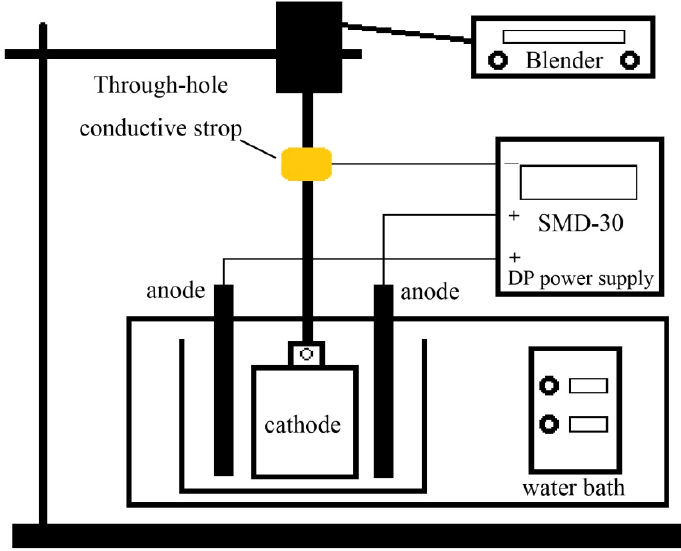
Table 1. Experimental parameter design.